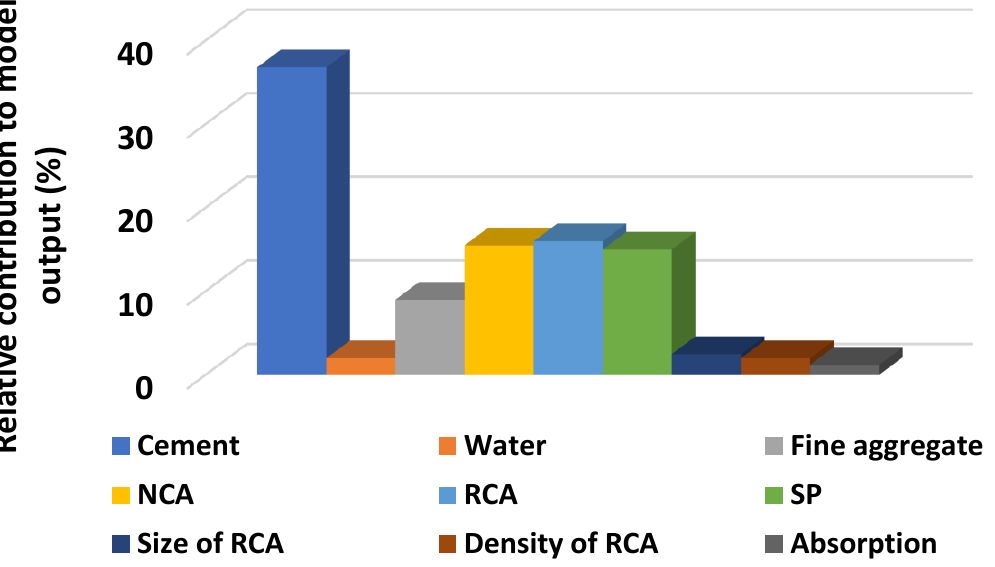
Figure 11. Contributing level of the input variables towards the prediction of output for CS.